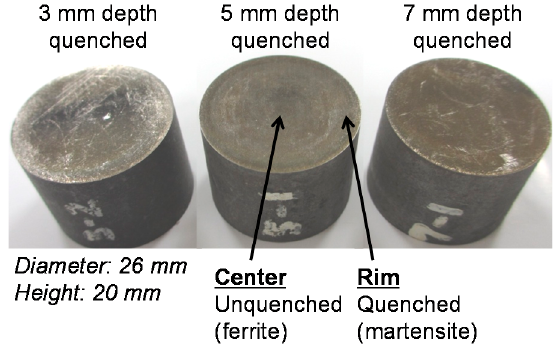
Figure 11. Photograph of three types of quenched rod [6].